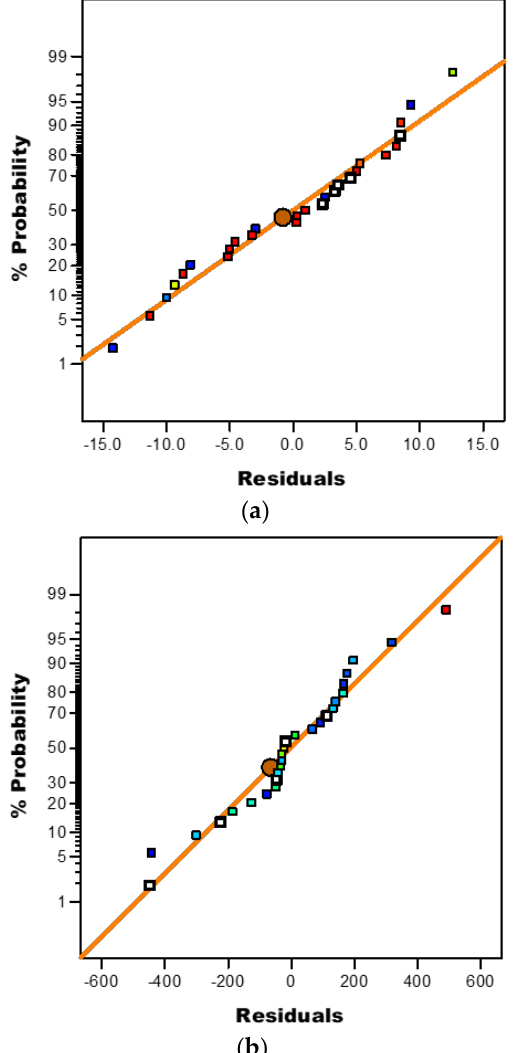
Figure 7. The normal probability plots for the As removal efficiency ( a ) and the bed saturation time ( b ).